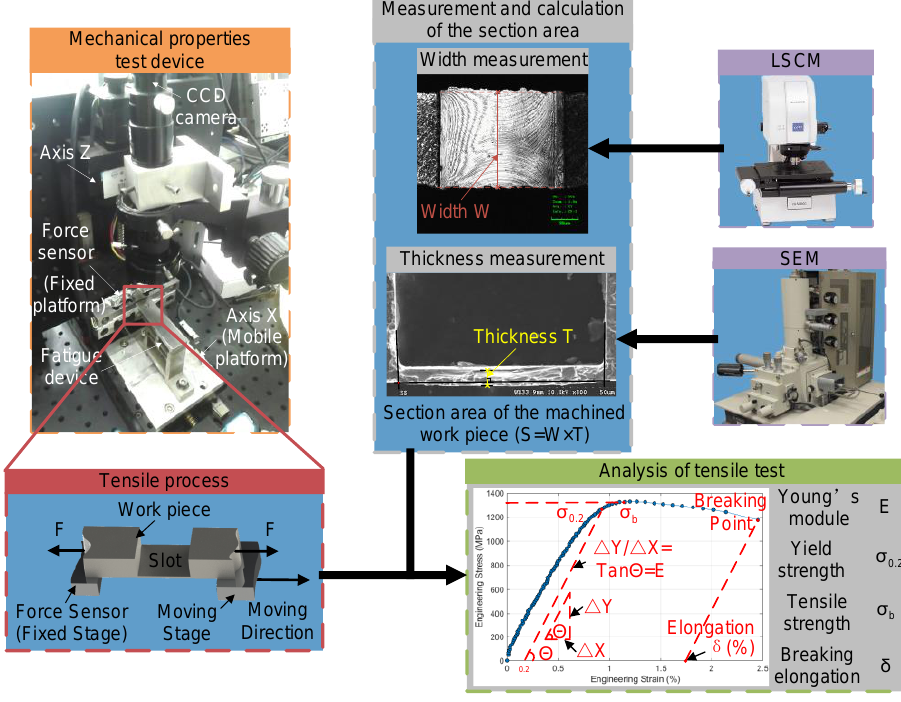
Figure 3. Sketch of testing mechanical properties.